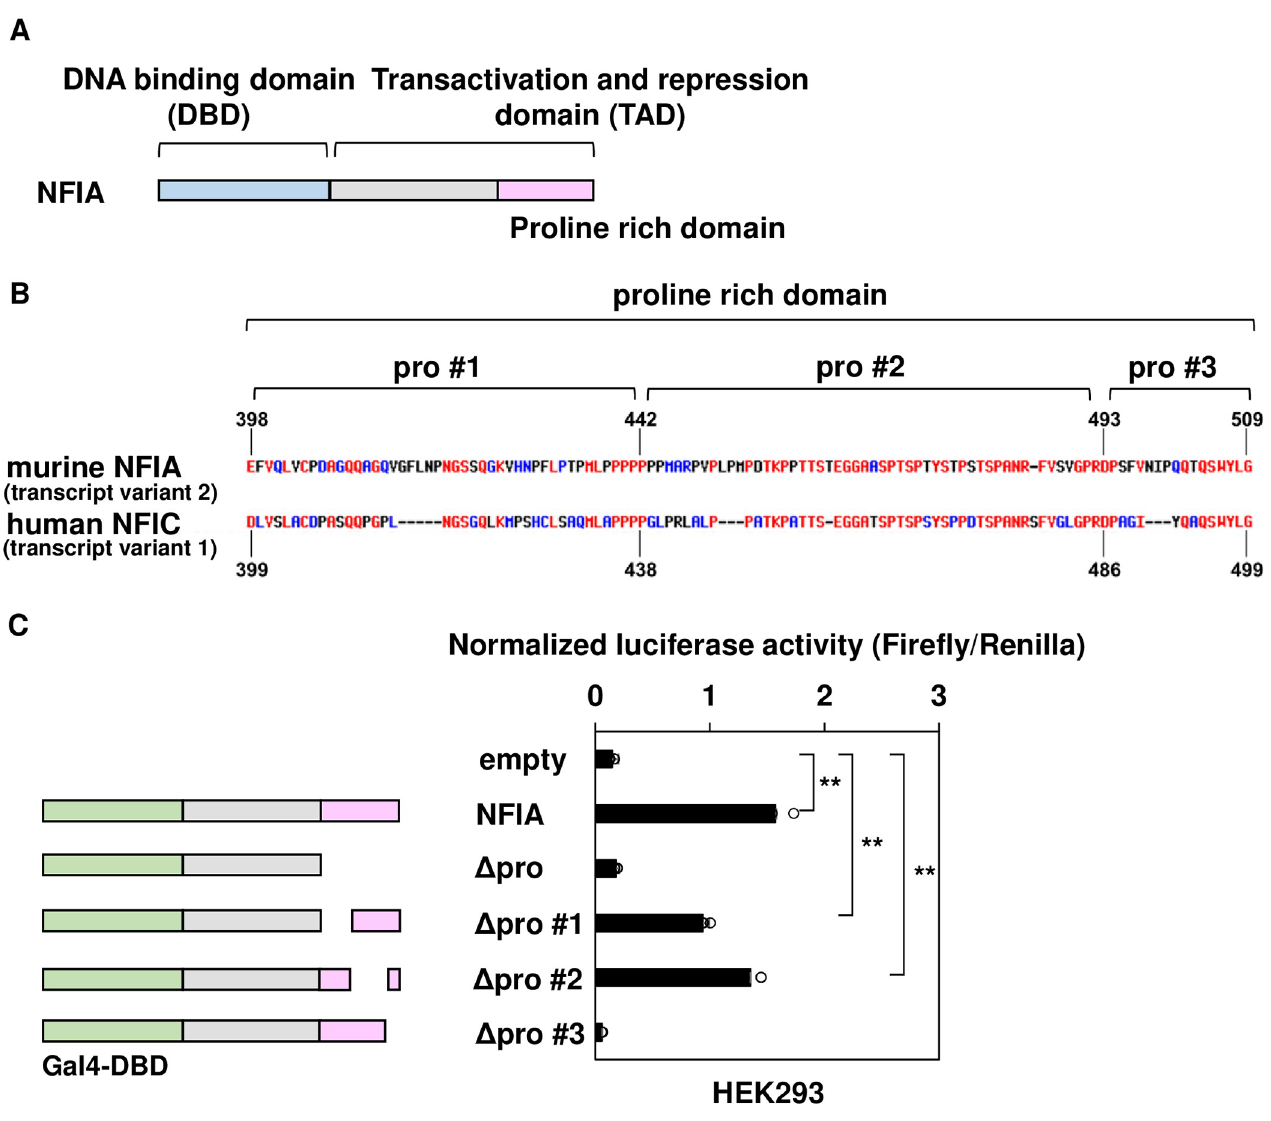
Fig 1. The C-terminal proline rich domain is required for the transcriptional activity of NFIA. (A) A diagram showing the domain structure of NFIA. DNA binding domain (DBD) is shown in blue, proline-rich domain is shown in pink, and transactivation domain (TAD) is shown in gray and pink combined. (B) A detailed diagram showing the C-terminal proline rich domain of murine NFIA, variant 2 as well as human NFIC, variant 1. (C) Transcriptional activities of full-length and mutant NFIA examined by luciferase reporter assay. (mean +/- S.E.M.; N = 4; �� P < 0.01).